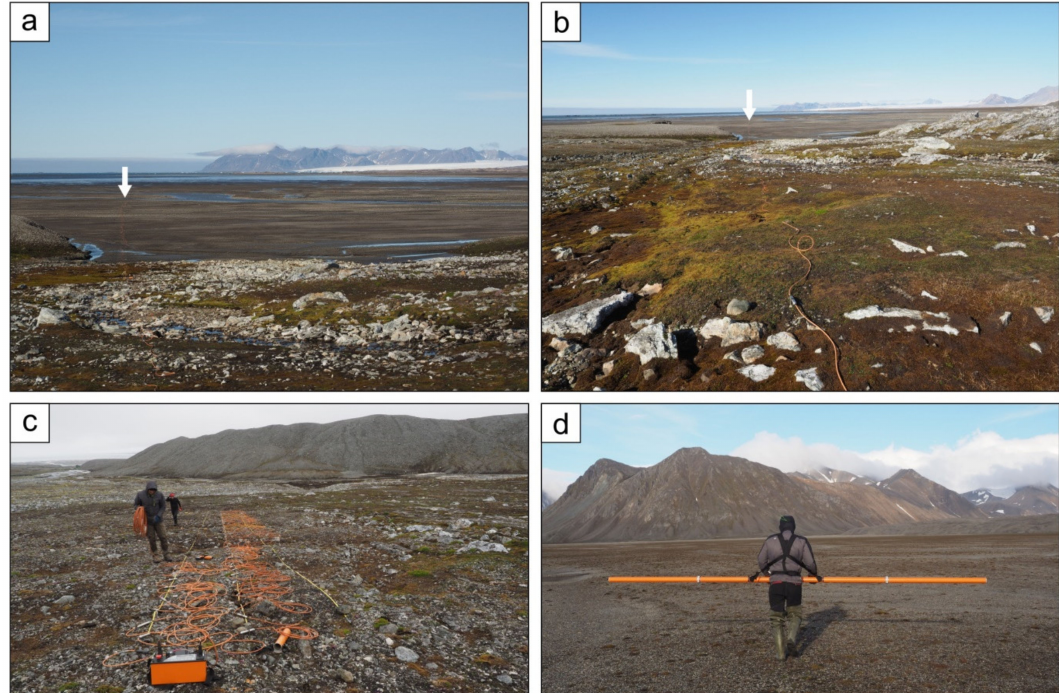
Figure 2. Illustrative photos documenting the study area and research methods: ( a ) the exposed bottom of Nottinghambukta (bay) during low water spring tide, the arrow marks the beginning of the ERT section, ( b ) the same ERT section from the hinterland, ( c , d ) ERT and EMI devices (during measurements at other sites). Photographed by M.